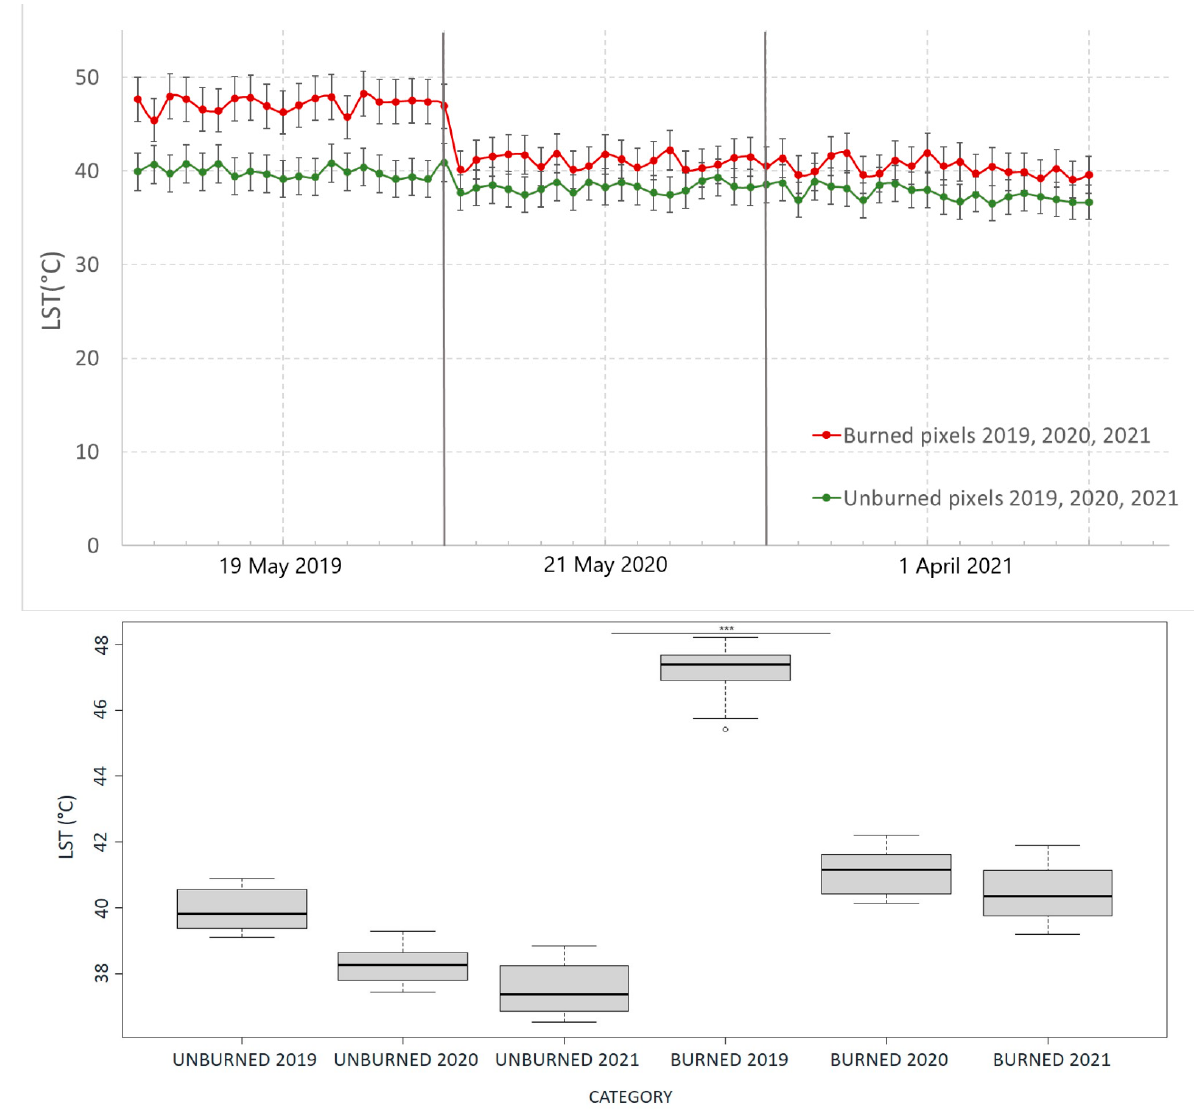
Figure A1. Pixel-level LST of burned and unburned sites for the years 2019, 2020, and 2021 ( upper figure) and box-plot including the level of statistical significance ( bottom ; p < 0.001 ***).